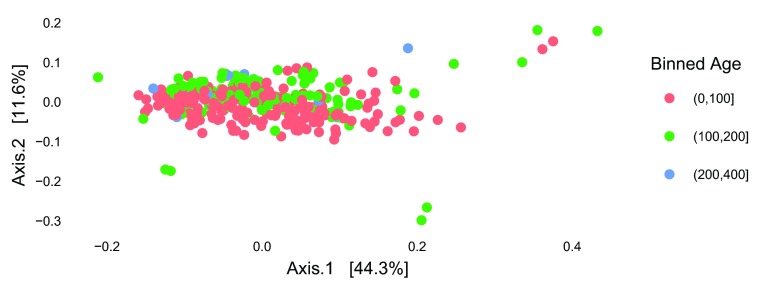
An ordination on the logged abundance data reveals a few outliers.